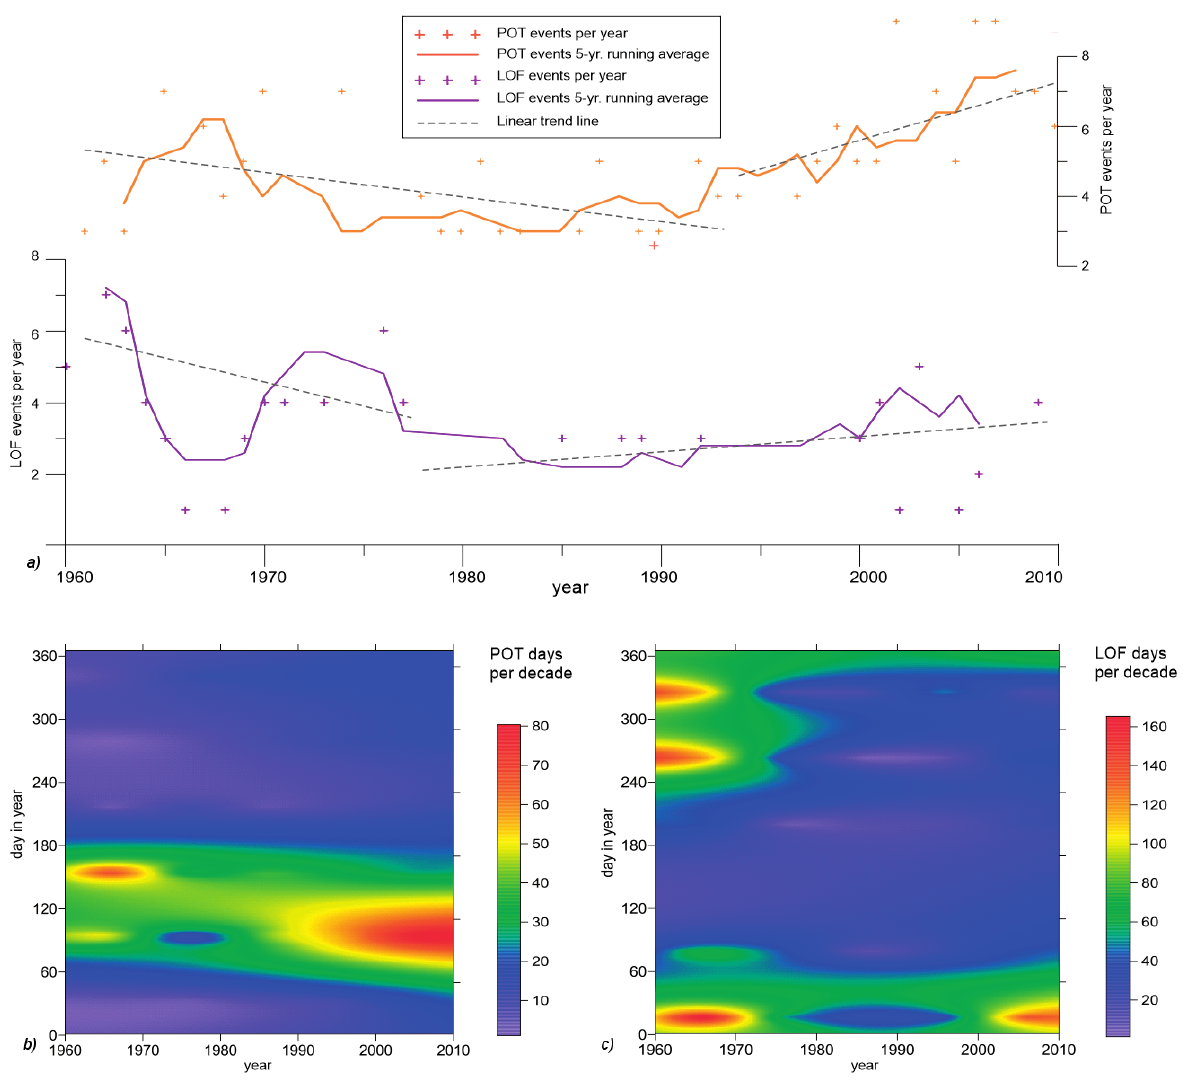
Figure 9. Patterns of frequency and seasonality of peak and low flows during 1961–2010: ( a ) occurrence of peak flows events, ( b ) changes in frequency and seasonality of days with POT; and ( c ) changes in frequency and seasonality of days with LOF. The trend lines